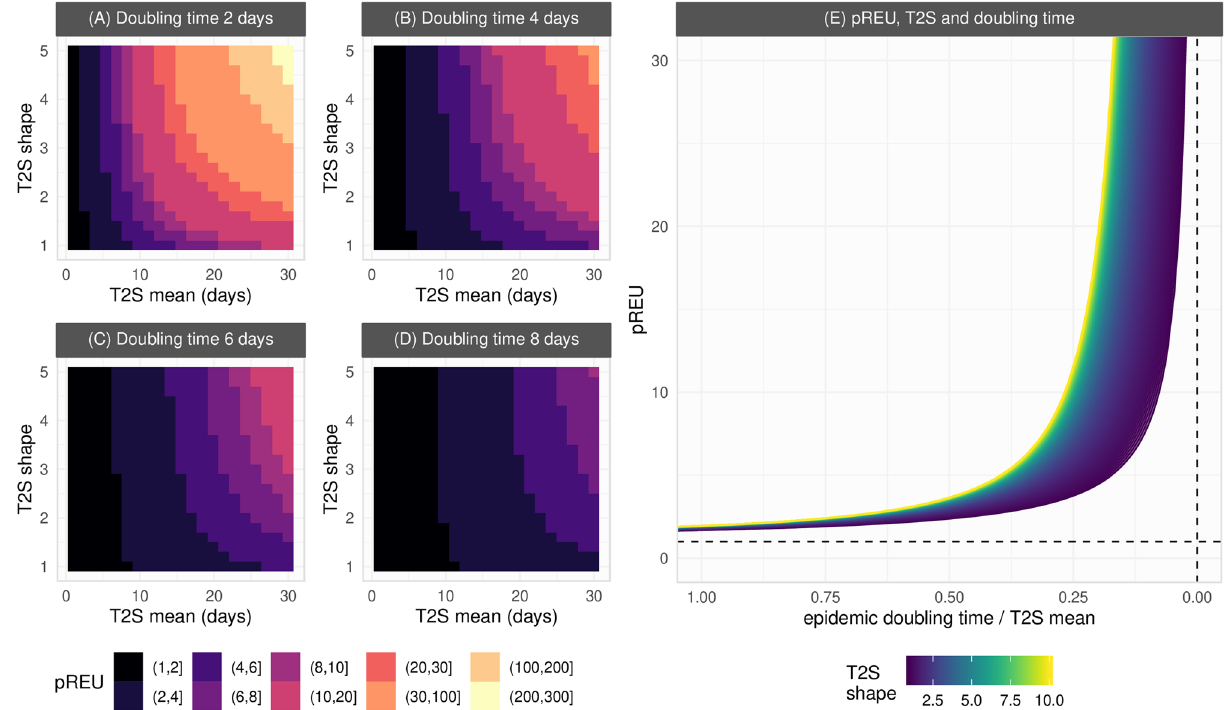
larger variance in responses among hosts). The color scale is discretized for visualization. ( E ) Sensitivity of pREU when varying doubling time, T2S mean and shape. Dashed lines present the limits pREU = 1 and doubling time / T2S mean = 0. T2S mean varied from 1 to 100, T2S shape from 1 to 10, doubling time 1 to